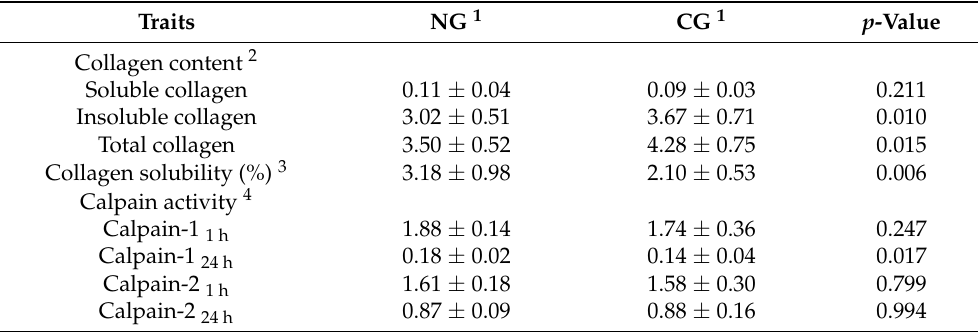
Table 3. Collagen content and calpain activity in Longissimus thoracis m. of Southern Thai native goats (NG) and Three-way crossbred goats (CG). Traits